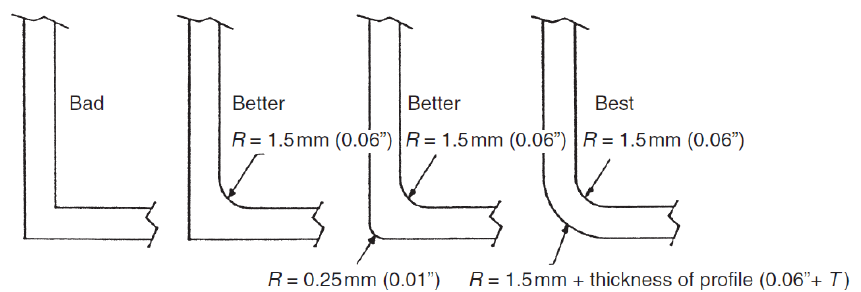
Figure 15. Recommended configurations of the corner of PFRP profiles [192].